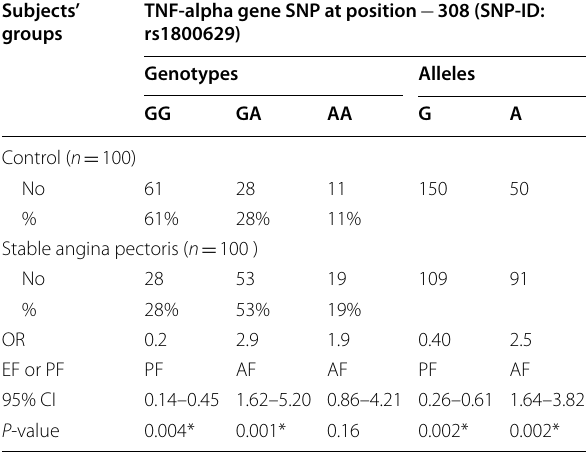
Table 4 Genotype and allele frequencies of TNF-alpha